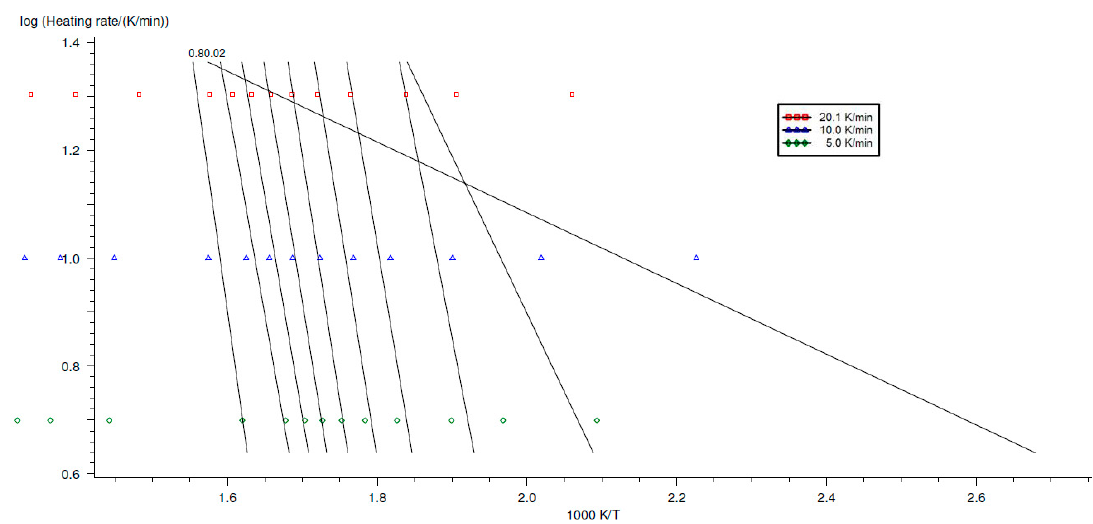
Figure 5. Graph of dx / dt logarithm as a function of temperature inverse of Ozawa–Flynn–Wall method for an oat straw sample.